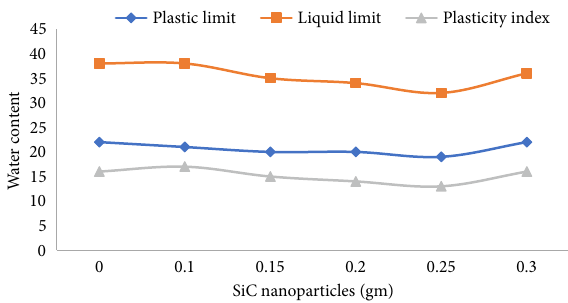
Figure 1. Effect of SiC nanoparticles and water content on engineering properties of soil